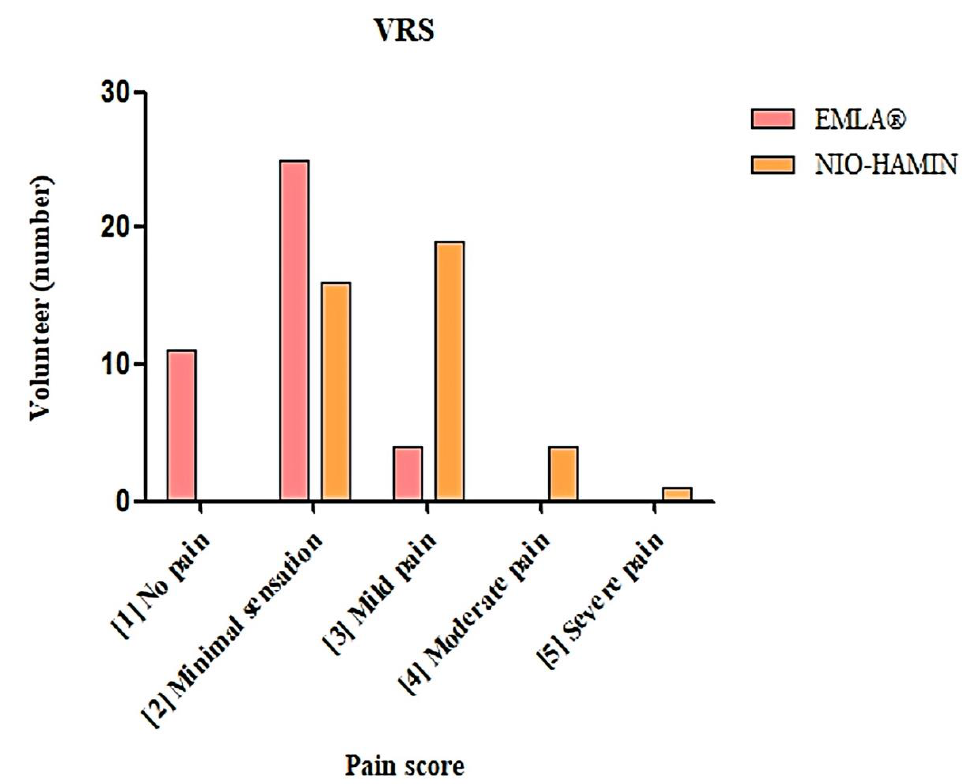
Figure 9. Verbal rating score (VRS) for NIO-HAMIN F1-C emulgel compare to EMLA ® cream. Values are presented as the number of subjects vs. pain score ( n = 40, p < 0.05). (2) Study 2